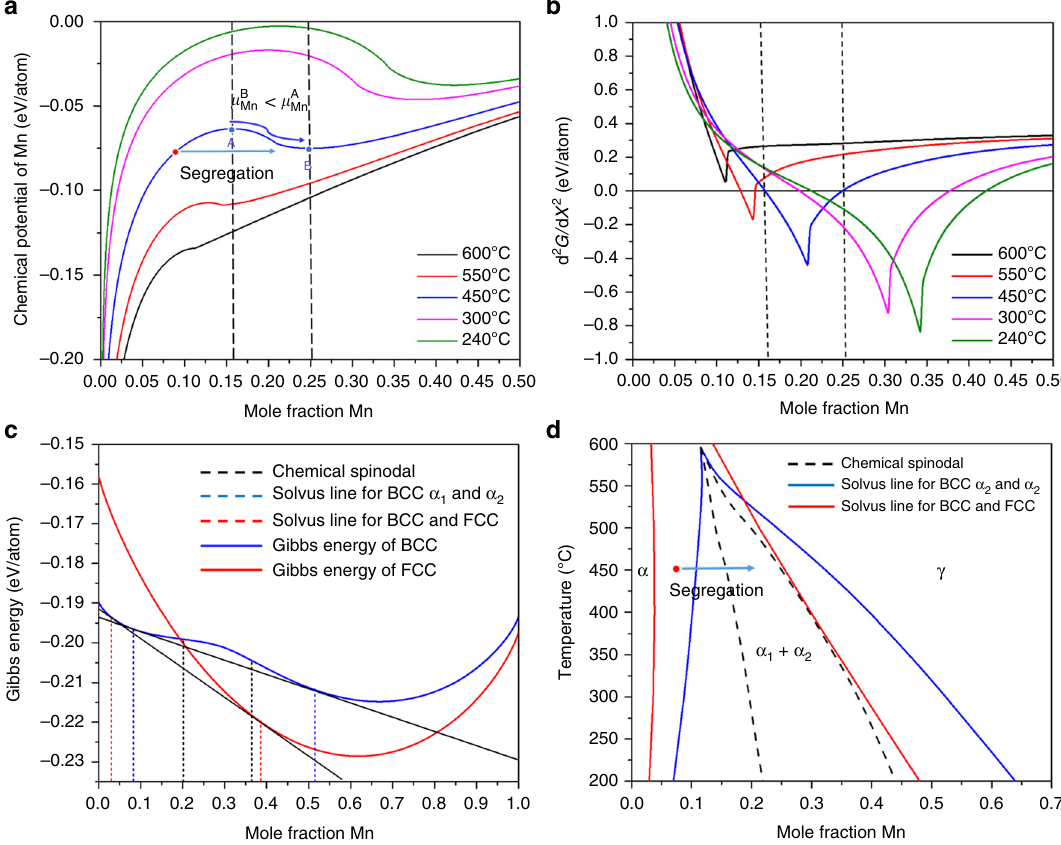
Fig. 3 Thermodynamic calculations for the BCC Fe-Mn bulk system. a Chemical potential of Mn as a function of the mole fraction of Mn for different temperatures. The black dashed lines indicate the spinodal points at 450 °C. b Second derivative of the Gibbs free energy in function of the molar fraction of Mn. c Gibbs free energy of the BCC and FCC phases at 300 °C showing the bulk chemical spinodal of the BCC phase and the local equilibrium obtained by the tie-lines among the different phases. d Fe-Mn bulk phase diagram including the chemical spinodal, the solvus lines between BCC and two spinodal compositions α 1 and α 2 and the solvus lines for the composition in equilibrium between BCC (ferrite) and γ FCC (austenite). The red point in a , d indicates the initial composition of the system and the arrows indicate the solute enrichment due to